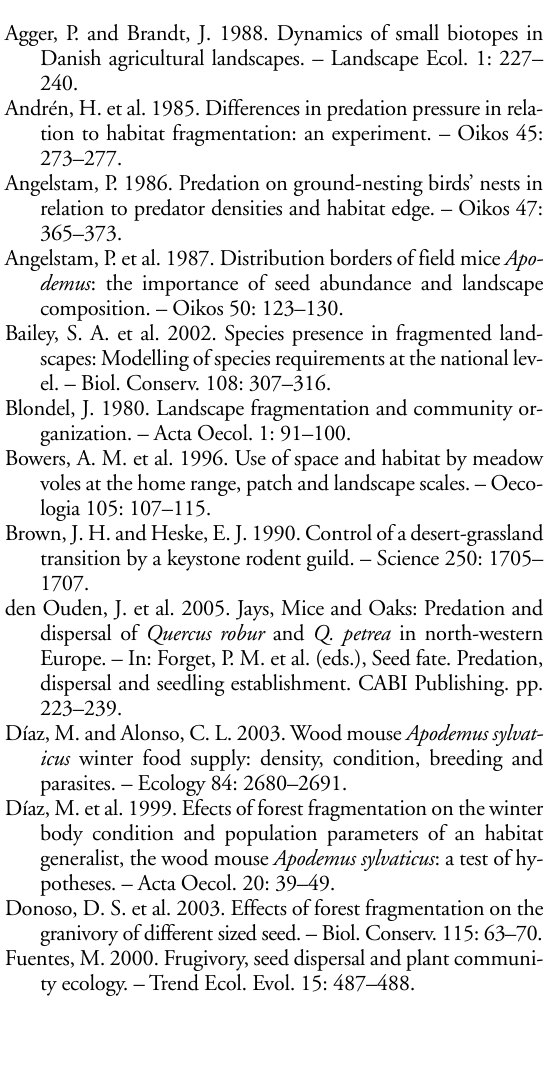
% of grid points covered